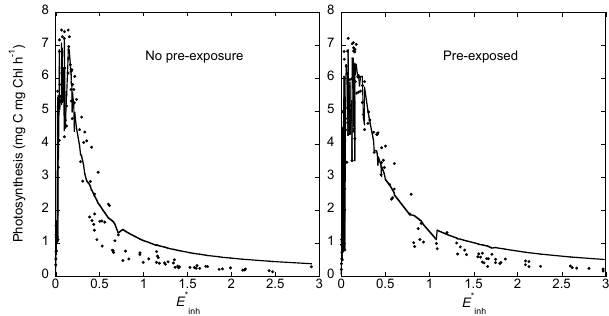
Figure 5. Observed (points) and fitted (lines) photosynthesis of Synechococcus as a function of weighted UV+PAR exposure for two cultures (both WH8102 ML 26 ◦ C), for which, prior to a stan- dard 1h incubation in the photoinhibitron, one was maintained un- der growth conditions and the other exposed to moderate UV+PAR (no pre-exposure or pre-exposed, respectively; see details in Ma- terials and methods). Solid line shows the fitted values from the BWF E /P-E max